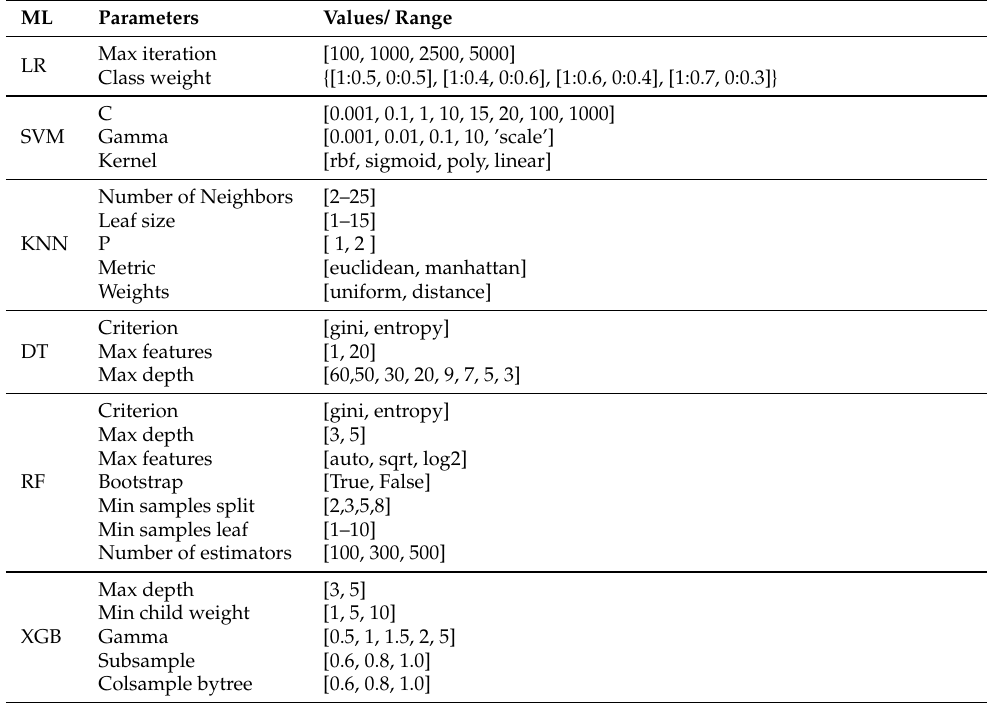
Table 6. Hyperparameter tuning space for ML